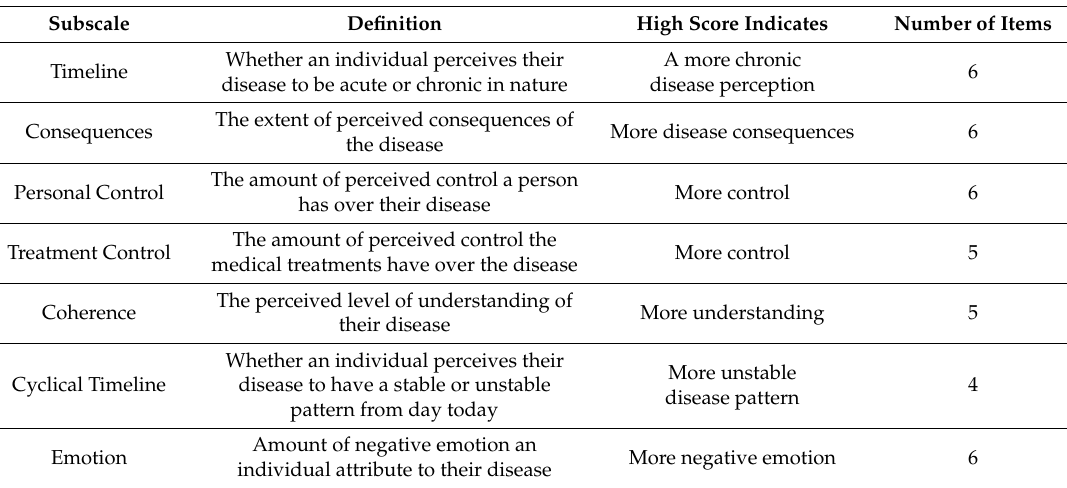
Table 1. Details of the IPQ-R